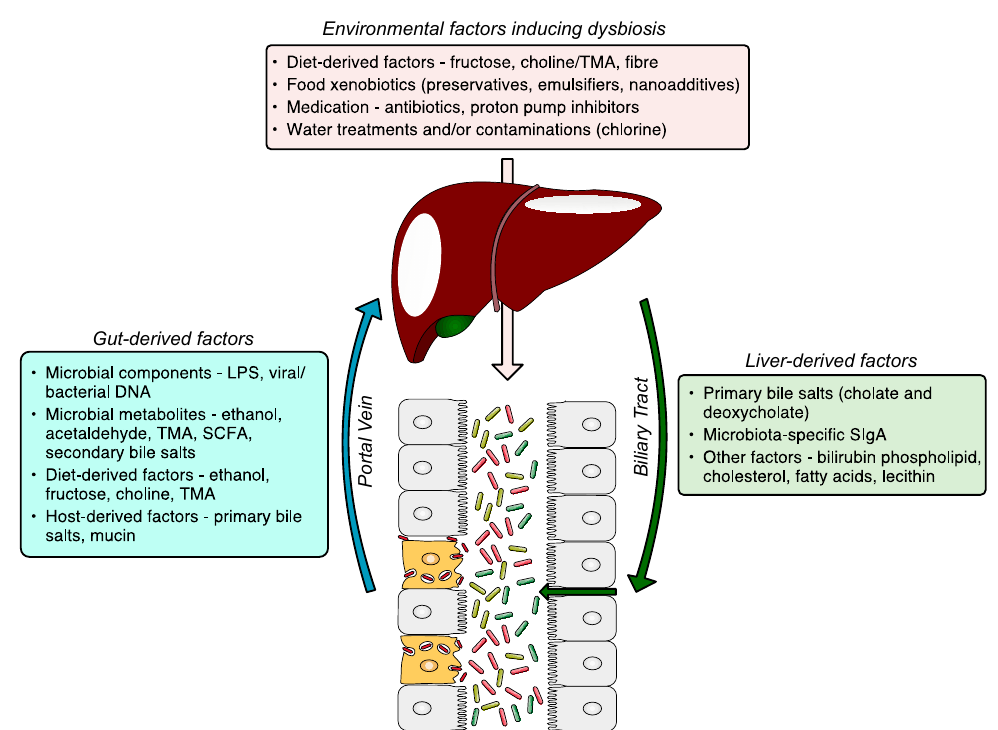
Figure 1. The gut–liver axis and the role of the gut microbiome in the pathogenesis of NAFLD. The gut microbiome altered by environmental factors induces hepatic steatosis. The dysfunctional liver fails to restore gut eubiosis, which results in a vicious self-perpetuating loop, promoting NAFLD progression. The communication via systemic mediators is not shown. NAFLD, non-alcoholic fatty liver disease; MAMP, microbe-associated molecular pattern; LPS, lipopolysaccharide; TMA, trimethylamine; SCFA, short-chain fatty acid; DCA, deoxycholic acid; CDCA, chenodeoxycholic acid.